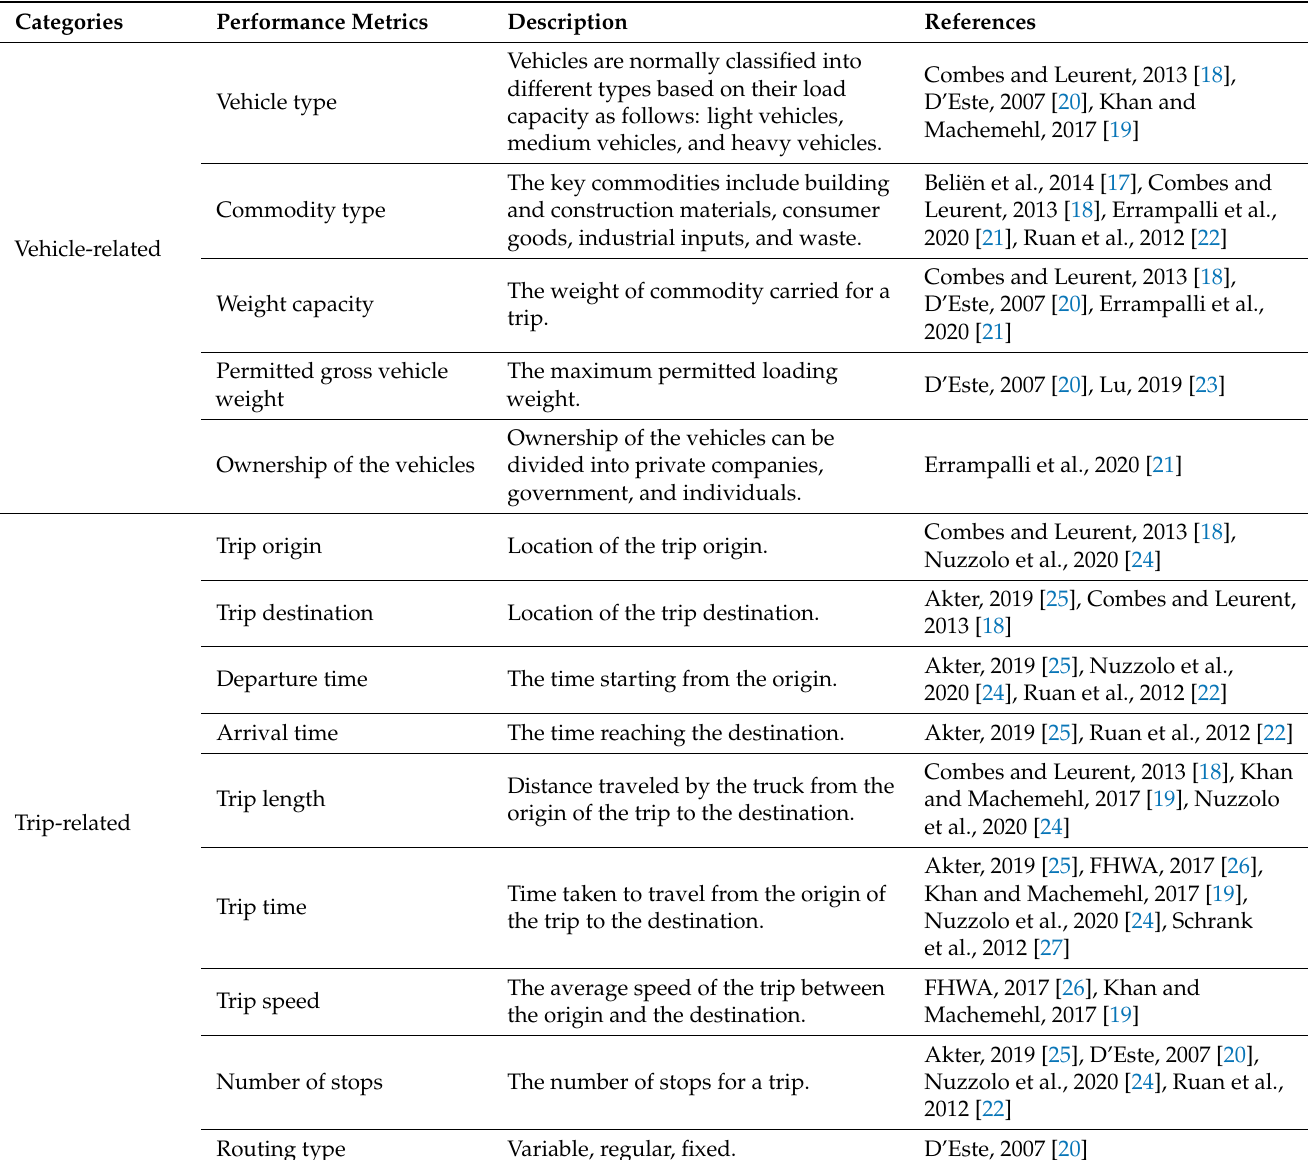
Table 1. List of freight performance